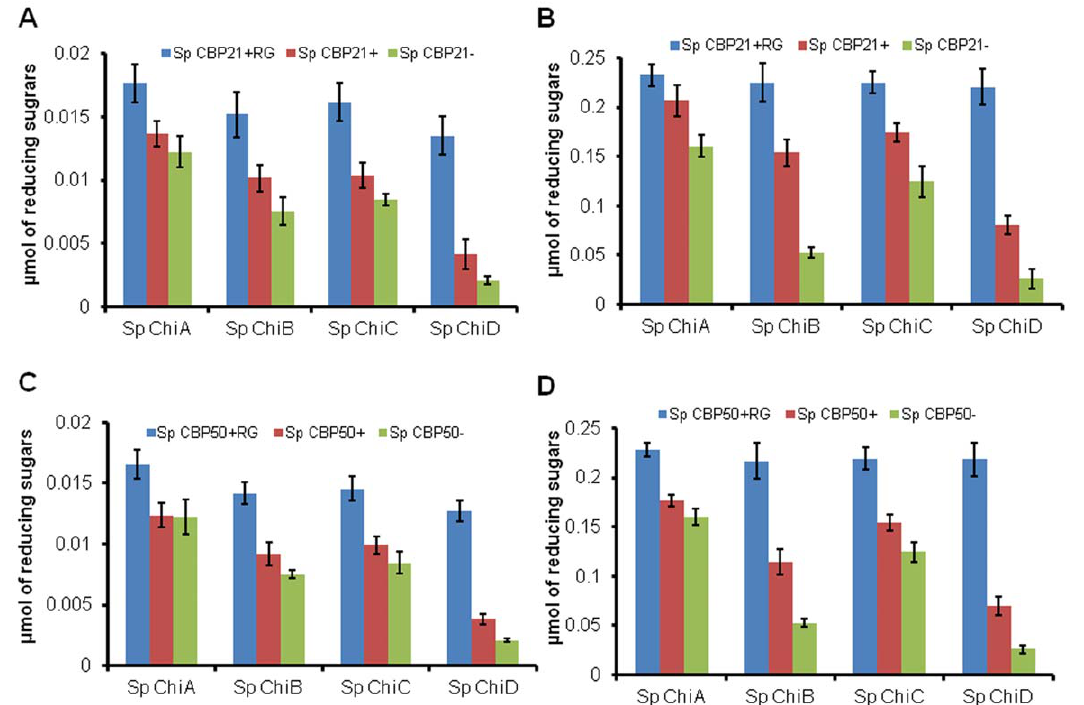
Figure 5. Degradation of a - and b -chitin by Sp chitinases in the absence or presence of Sp CBP21, Sp CBP50 and reduced glutathione. Reaction mixture (1 mL) containing 0.25 mg/mL of chitin substrates ( a - and b -chitin), 1 m M of Sp chitinase ( Sp ChiA/ Sp ChiB/ Sp ChiC/ Sp ChiD) were incubated with 0.3 m M Sp CBP21 or Sp CBP50 and 1.0 mM reduced glutathione in 50 mM sodium phosphate buffer pH 7.0. After incubation at 37 u C for 7 days at 1000 rpm, after every 24 h, 100 m L of reaction mixture was transferred. To this 100 m L of 0.02N NaOH was added to stop the reaction and stored at 2 20 u C until products quantification by standard reducing end assay. Vertical bars represent standard deviation of triplicate experiments. (A and B) Degradation of a - and b -chitin by Sp chitinases in the presence/absence of Sp CBP21 and reduced glutathione (RG), (C and D) degradation of a - and b -chitin by Sp chitinases in the presence/absence of Sp CBP50 and reduced glutathione (RG). Sp CBP21 + RG or Sp CBP50 + RG: Sp CBP21/ Sp CBP50 and reduced glutathione, Sp CBP21 + or Sp CBP50 + : only Sp CBP21/ Sp CBP50 without reduced gluthathione, Sp CBP21- or Sp CBP50 -: without Sp CBP21/ Sp CBP50 and reduced glutathione.